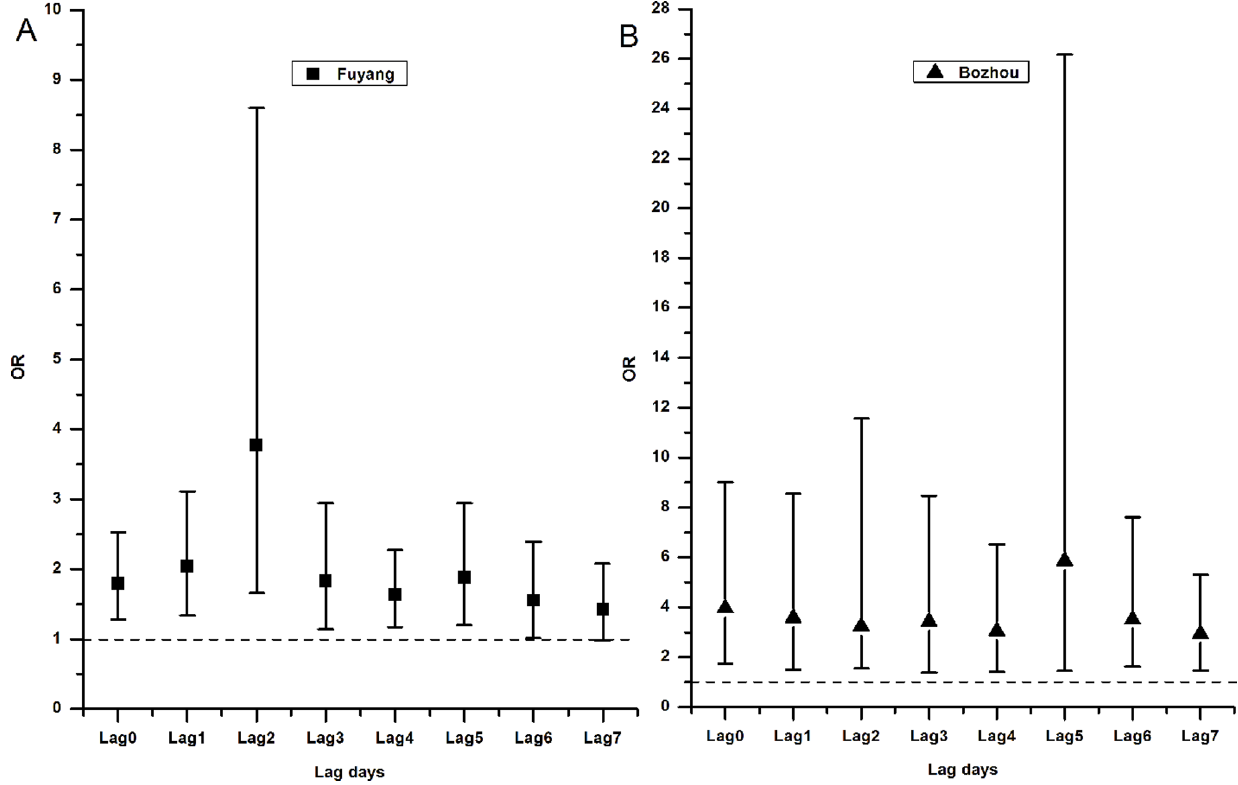
Figure 3. OR estimates of the floods on the risk of infectious diarrhea in different lagged days.